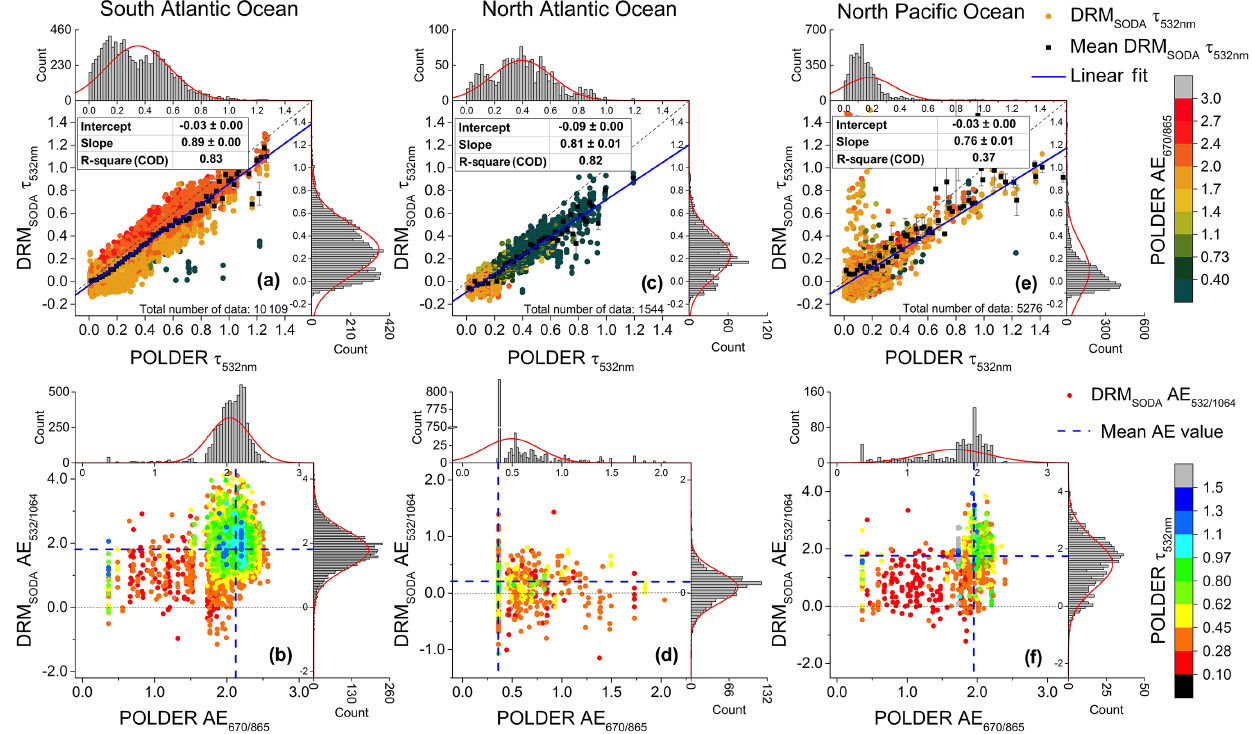
Figure 3. The first row of the panel shows the comparison of AOT at 532nm retrieved from DRM SODA and POLDER methods, with the corresponding POLDER AE colour scale, computed between 670 and 865nm. The second row presents the Ångström exponent comparison for AOTs larger than 0.1, retrieved from DRM SODA and POLDER methods, with the corresponding POLDER AOT at 532nm colour scale. The measurements were made over a period of 6 months (May to October 2008) and over three distinctive regions: South Atlantic Ocean, between 30 ◦ S and 5 ◦ N and 12 ◦ W and 14 ◦ E (a, b) ; North Atlantic Ocean, between 10 and 35 ◦ N and 10 and 40 ◦ W (c, d) ; and North Pacific Ocean, between 35 and 60 ◦ N and 140 and 170 ◦ E (e, f) . The histograms present the data distribution. The error bars in (a) , (c) and (e) represent the standard error of the mean (SEM).